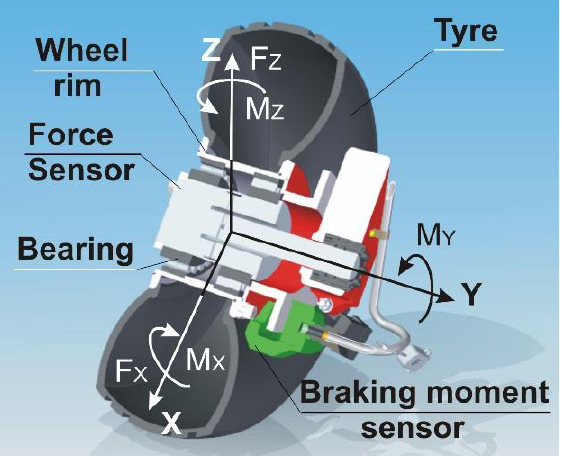
Figure 1. A schematic of the wheel sensor together with axes orientation and forces/moments system. The X , Y , and Z axes are mutually orthogonal.